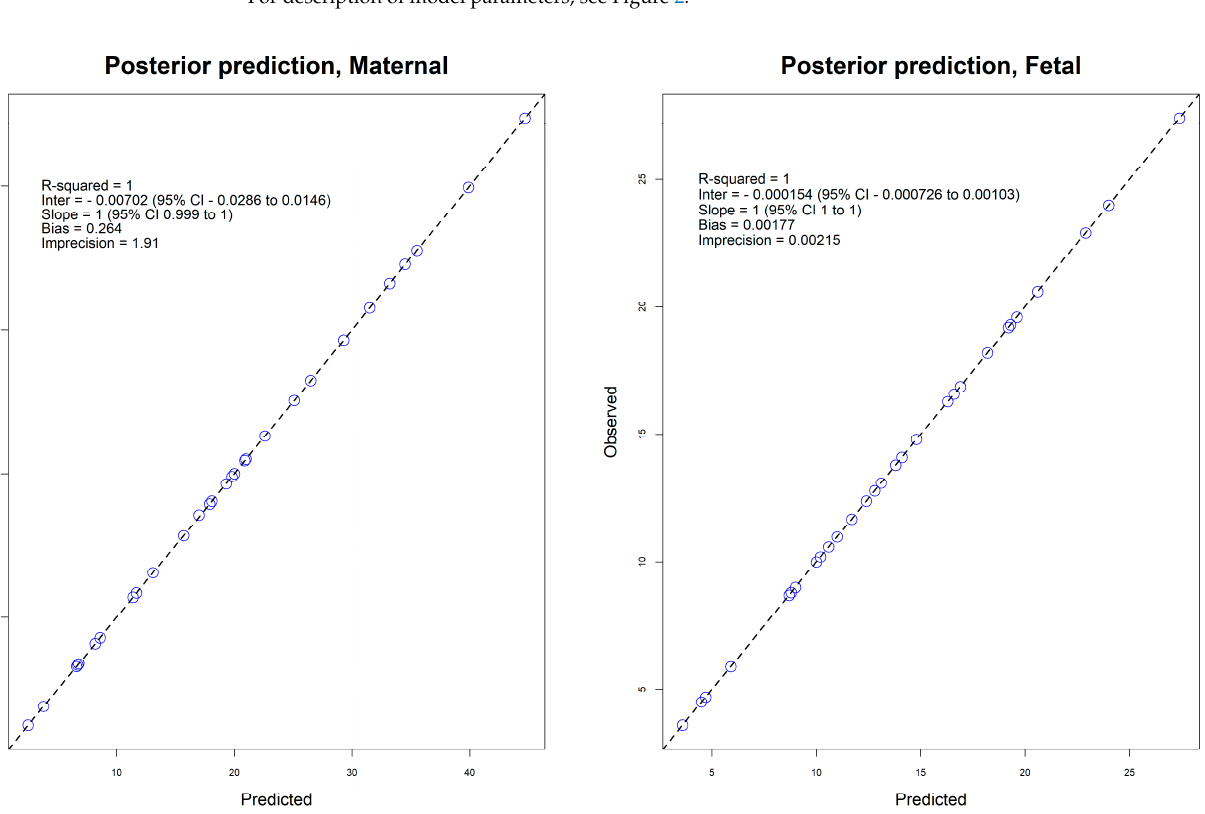
Figure 1. Plots of observed and predicted posterior individual serum concentrations.